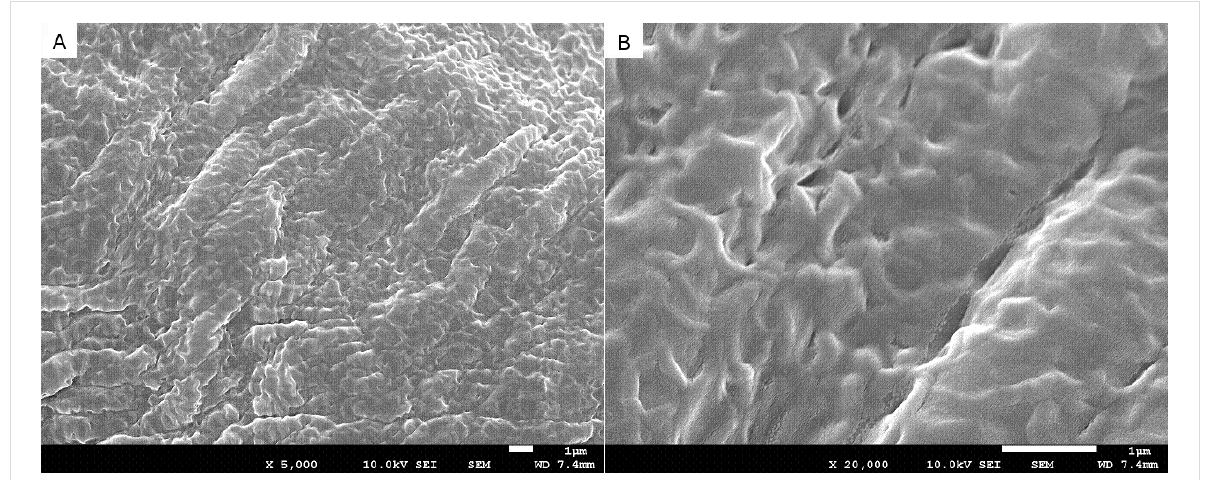
Figure 1: (A) SEM images of the xerogels of G3 from n -hexane (B) magnification of the xerogels structure.